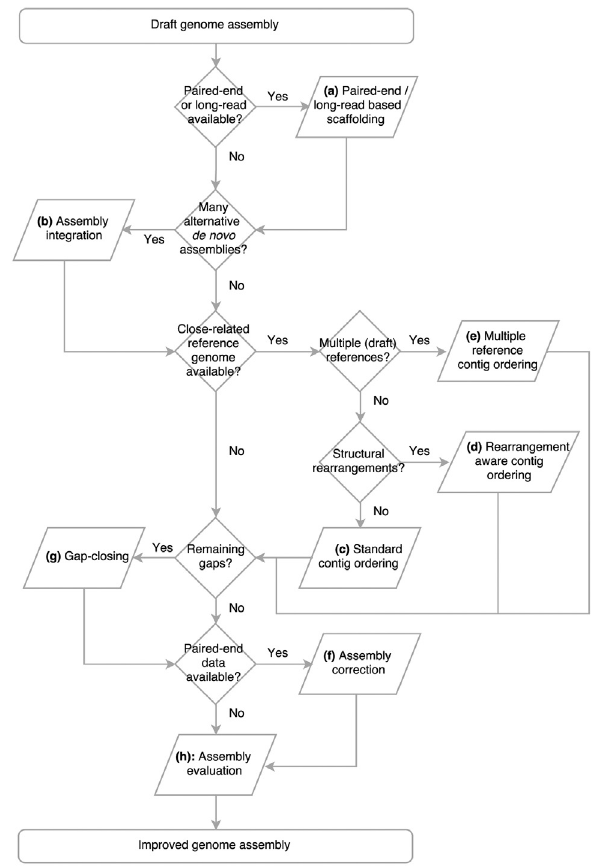
Figure 1 - A flowchart demonstrating how and when the different genome finishing approaches can be combined according to the data that is avail- able for the user. (a) Scaffolding using paired-end reads or long-reads , which is directly dependent on the way the genome was sequencing (plat- form, library), and sometimes performed as part of the de novo assembly process. (b) Assembly integration , which consists in the combination of different de novo assemblies and generation of a consensus/extended as- sembly. Some programs use only the assemblies as input, while others use also the sequencing reads. (c) The standard contig-ordering approach based on a single reference genome, which consists in the identification of synteny blocks that guide the orientation of the contigs in the draft ge- nome, without taking into count the occurrence of genome inversions otherrearrangements.(d)The rearrangement-awarecontig-ordering ,that identifies potential sites of inversion and translocations based on signa- tures on the alignment against the reference genome. (e) The multi- ple-referencecontigordering ,thatmaybemoreappropriateinthosecases where there is no finished reference genome, but there is a relatively high number of close-related drafts, or when there are no apparent closest refer- encetobeused.(f) Assemblycorrection ,whichconsistsintheremovingof short misassemblies, including base-substitutions and short insertions and deletions. (g) Gap-closing , which consists in the joining of adjacent contigs that used to be spaced by a gap. (h) Assembly evaluation , which may provide help to access the reliability of the